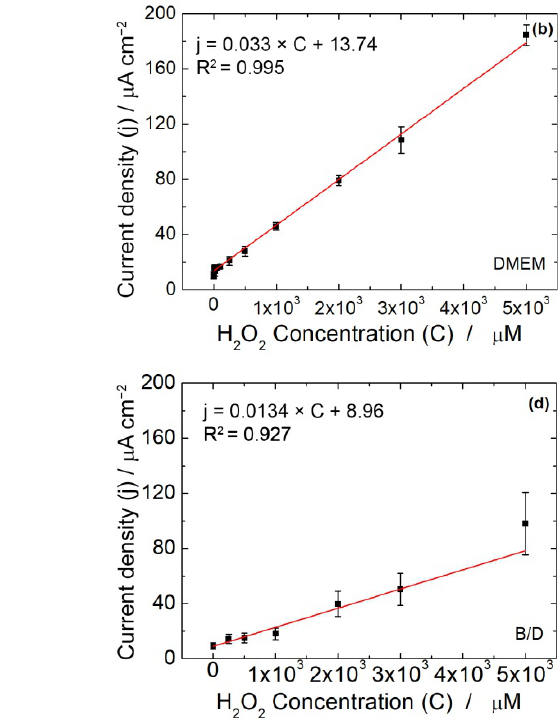
Figure 2. Calibration line obtained with CH at − 800 mV vs. SCE in ( a ) diluted MEM, ( b ) diluted DMEM, ( c ) diluted Ham’s F12 and ( d ) diluted B/D medium ( n = 3).